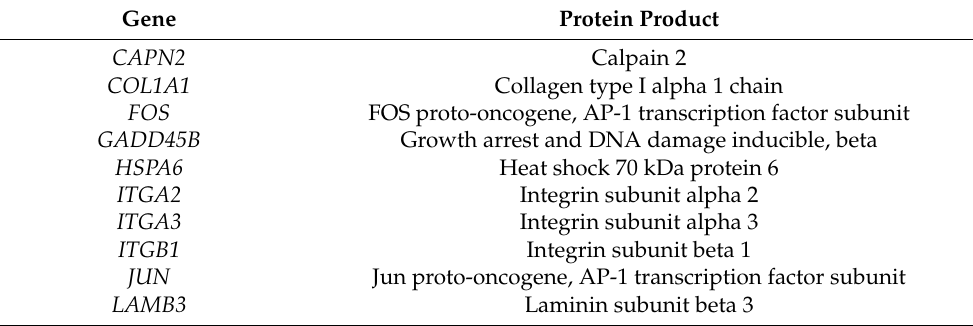
Table 5. PCR-validated up-regulated genes in HepG2 hepatocarcinoma cells exposed to 10 µ M CdCl 2 exposure